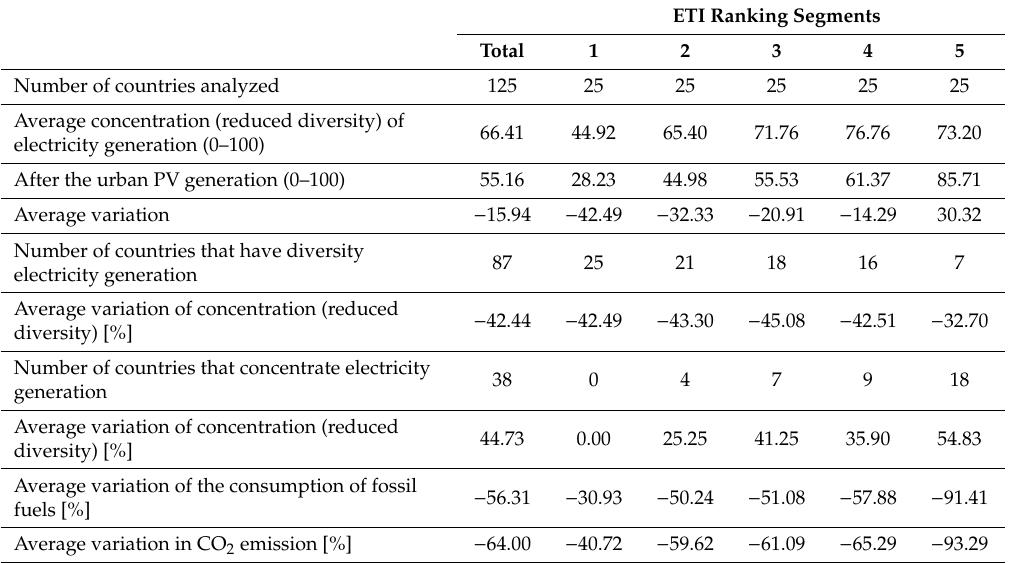
Table 2. Average results of the e ff ect of the diversification of the electric generation with urban PV generation in the ETI 2017